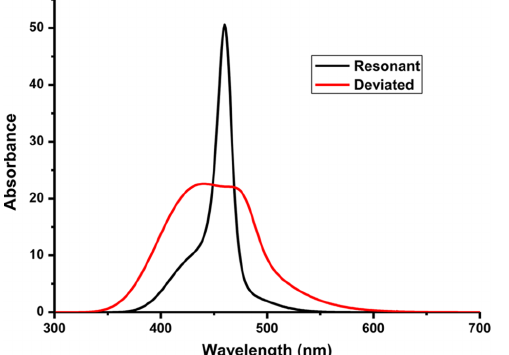
Figure 7. Change in theoretical spectra of J-aggregate with deflection from the nano-resonance condition (Equations (4)–(6)) [40]. The black line describes a J-band, consisting of L -peak and D -wing, with the following parameters: E = 0.2 eV, γ = 0.11 eV, L = 1.68 nm, J 1 = 5.5 eV, and J 2 = 3.72 eV; the red line describes a “J-band” with the following parameters: E = 0.4 eV, γ = 0.15 eV, L = 2.8